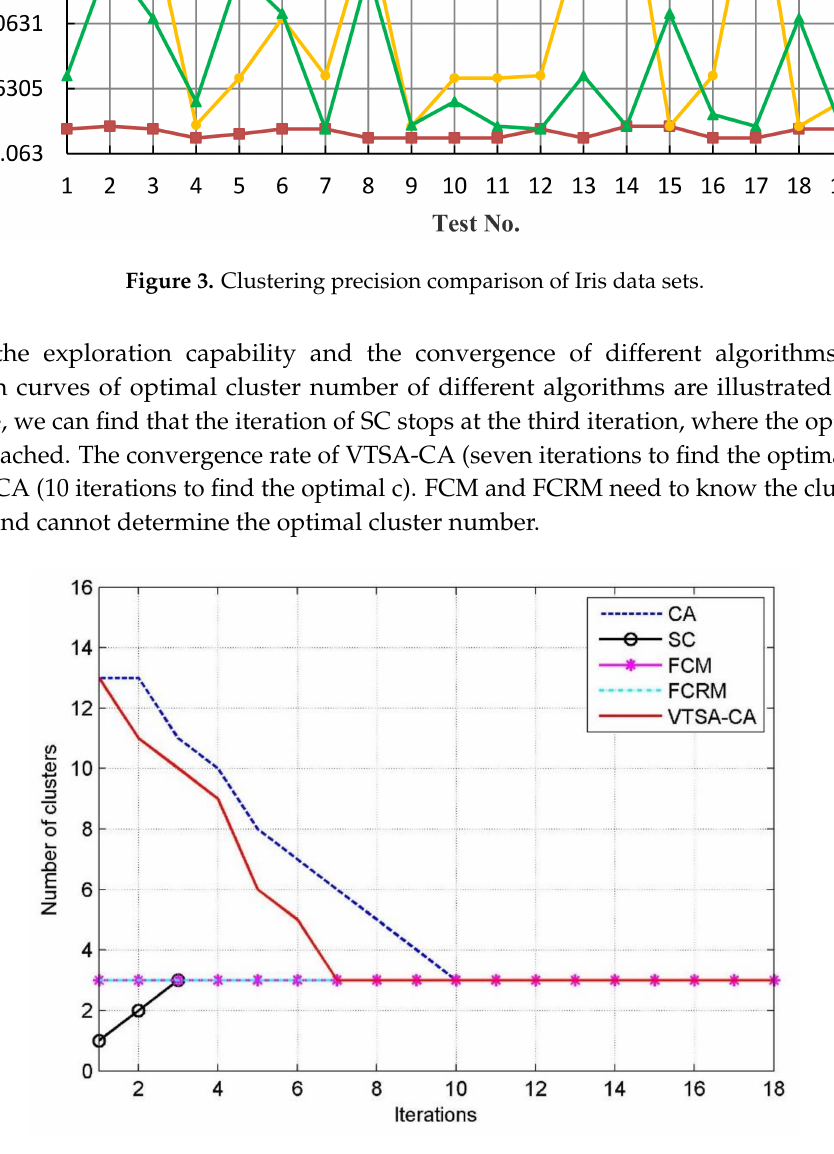
Figure 4. The iteration curves of optimal cluster number in different